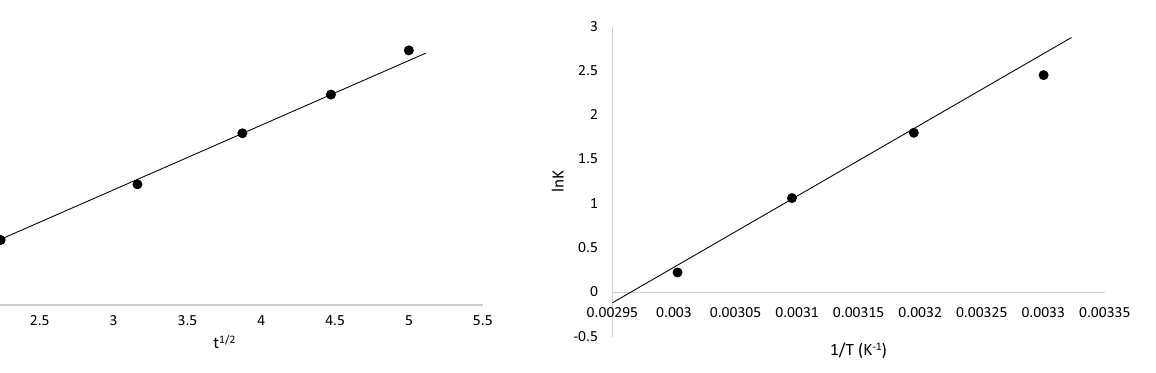
Fig. 13 Intra-particle diffusion of adsorption of Rh-B on AgNPs -0.500.51 Fig. 14 Boyd plot for adsorption of Rh-B on AgNPs